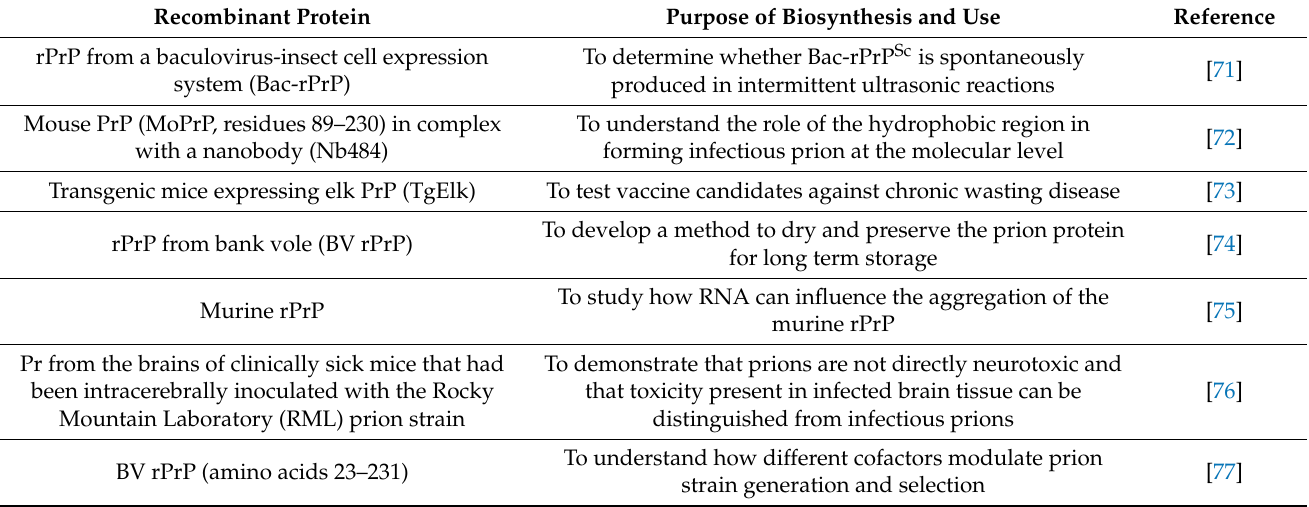
Table 2. Recombinant prion proteins and purposes of their biosynthesis and